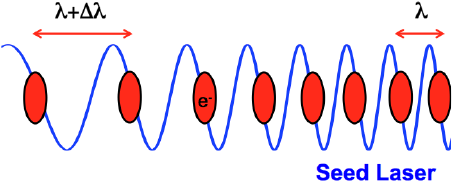
FIG. 1. Cartoon illustrating the effect of seed phase errors on HGHG electron bunching. A time-varying wavelength in the seed laser (blue line) results in a varying separation of the bunched electrons (red